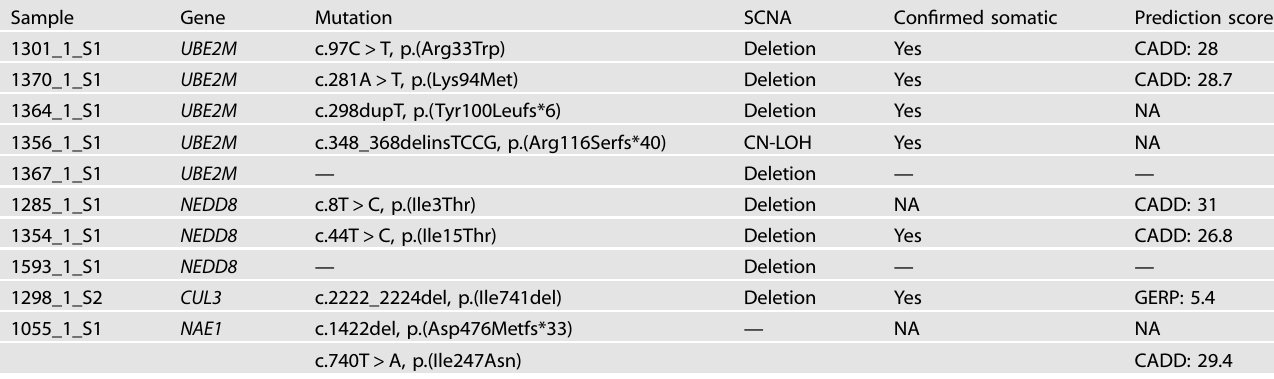
Table 2. Candidate driver mutations in AKR1B10hi tumors.